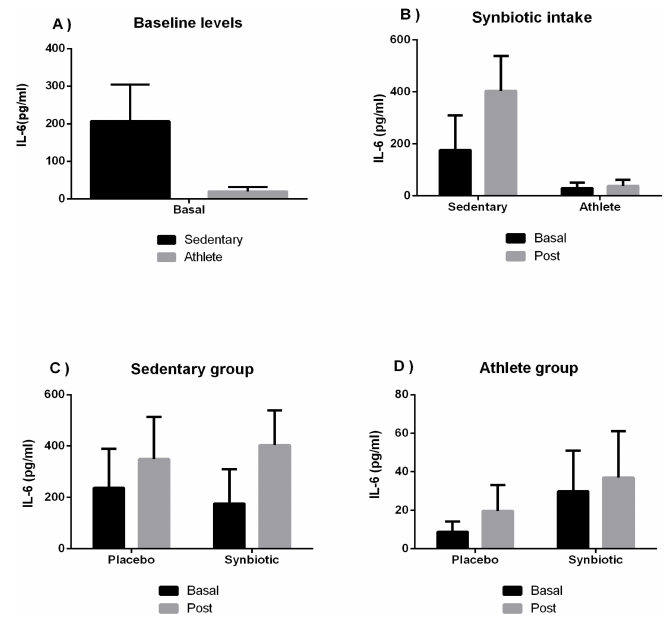
Figure 1. The effect of training and a synbiotic on the IL-6 cytokine. ( A ) Baseline serum IL-6 concen- trations in sedentary men (n = 14) and athletes (n = 13). ( B ) Training effects on synbiotic effects on serum IL-6 concentration (n = 7 and n = 6 in sedentary and athlete groups, respectively). ( C ) Effect of synbiotic consumption on IL-6 in sedentary individuals with placebo (n = 7) or synbiotic (n = 7). ( D ) Effect of synbiotic consumption on IL-6 in athlete individuals with placebo (n = 6). The determi- nations are expressed by the mean ± SD of each of the samples. No significant differences were seen between groups ( p > 0.05).